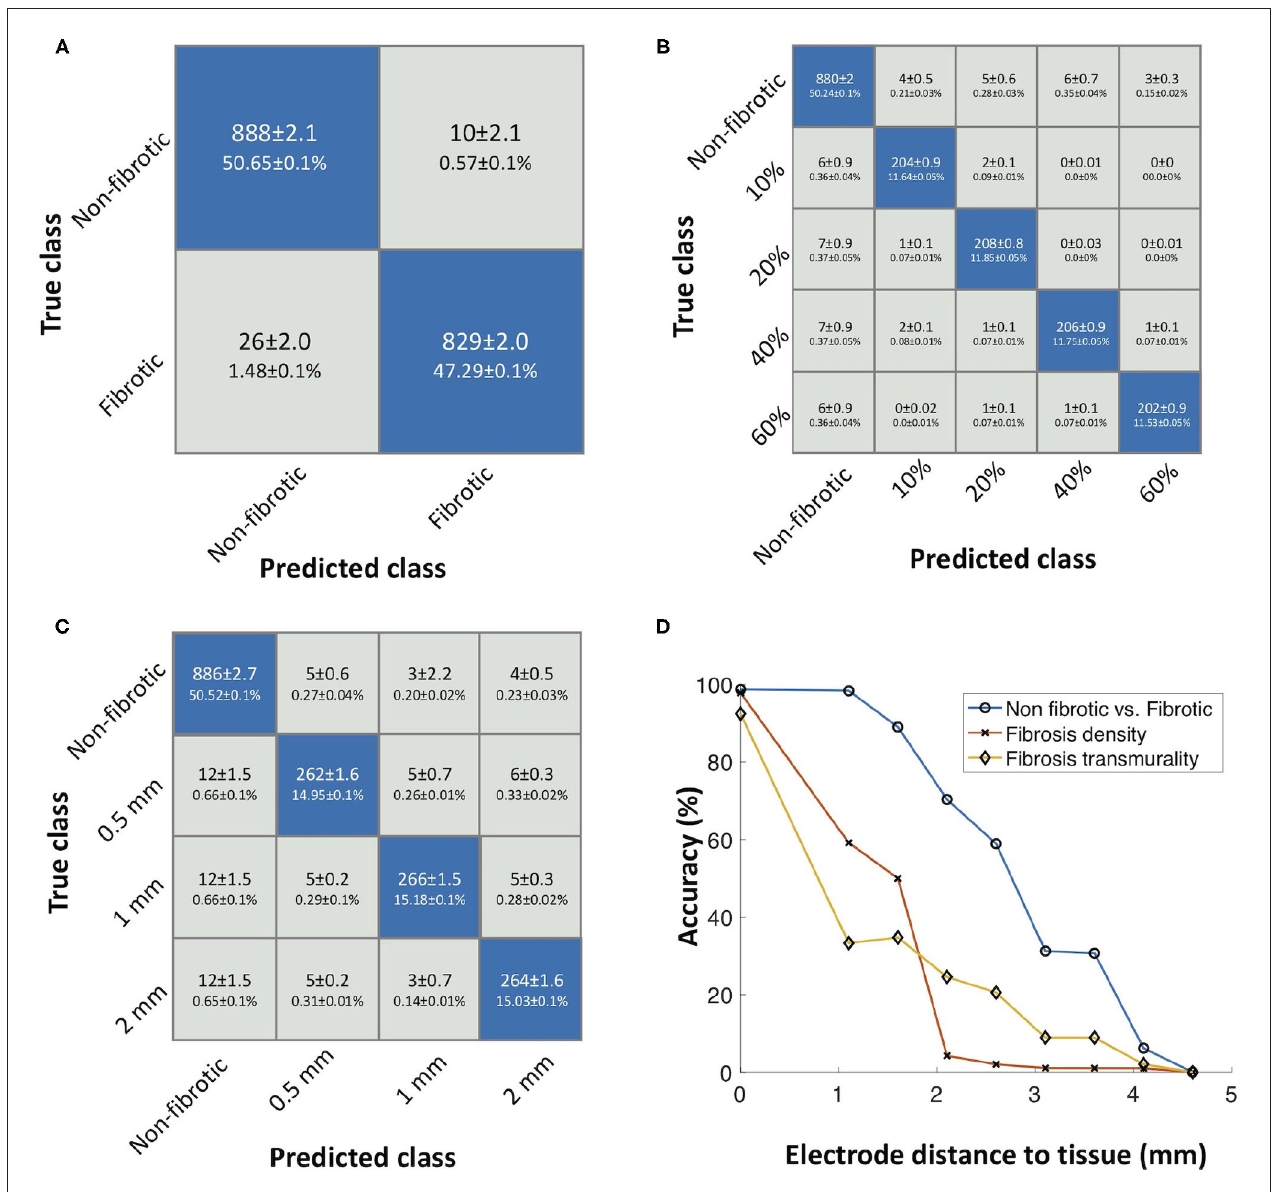
FIGURE 6 | (A) Confusion matrix of the decision tree classifier for identifying non-fibrotic vs. fibrotic substrate. (B) Confusion matrix showing the performance for identifying different fibrosis densities. (C) Confusion matrix showing the performance for identifying transmurality of fibrosis. (D) Effect of increasing the electrode surface to tissue surface distance on the accuracy of the classifiers to distinguish fibrotic tissue, density, and transmurality. Reused from Sánchez et al. (2021).